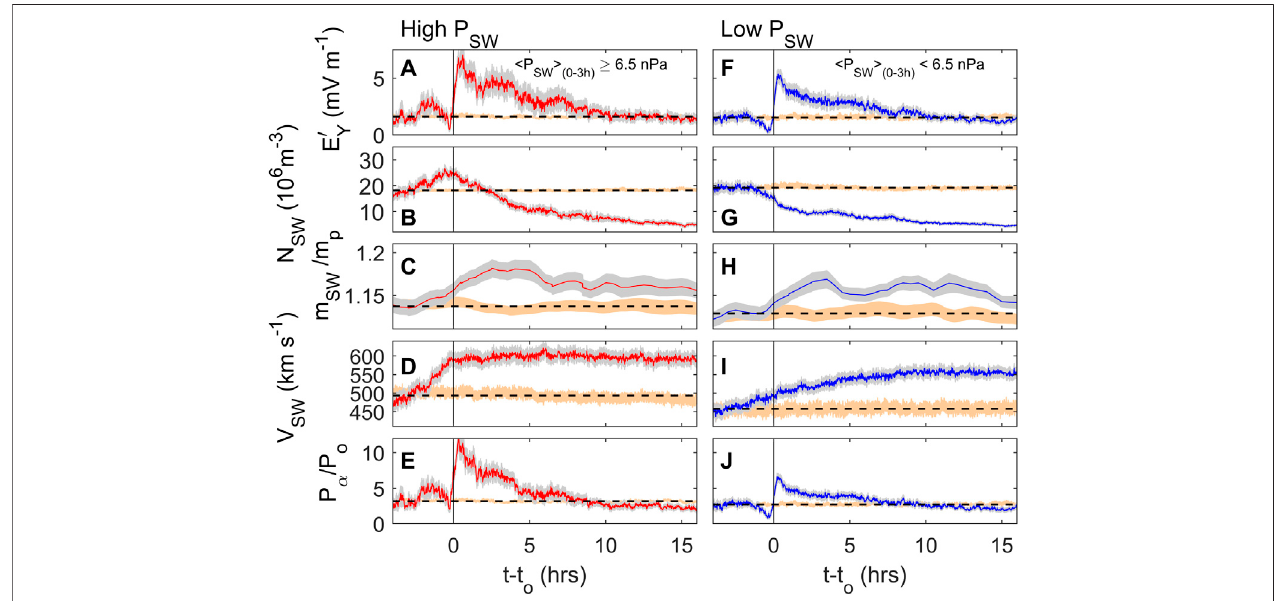
FIGURE11 | Superposed epoch study of theinterplanetary conditions for the events studied in Figure 9 .The left hand column are for the80 high- P SW southward turnings of the IMF and the right hand panels for the low- P SW set. From top to bottom panels are for: ( A and F ) the half-wave recti fi ed dawn-to-dusk electric fi eld, E Y ′ ; ( B and G ) the solar wind number density, N SW ; ( C and H ) the solar wind mean ion mass in amu m SW / m p ; ( D and I ) the solar wind speed, V SW ; and ( E and J ) the estimated power input into the magnetosphere, P α , as a ratio of its overall mean value, P o , as computed by the procedure and formulae of Vasyliunas et al.